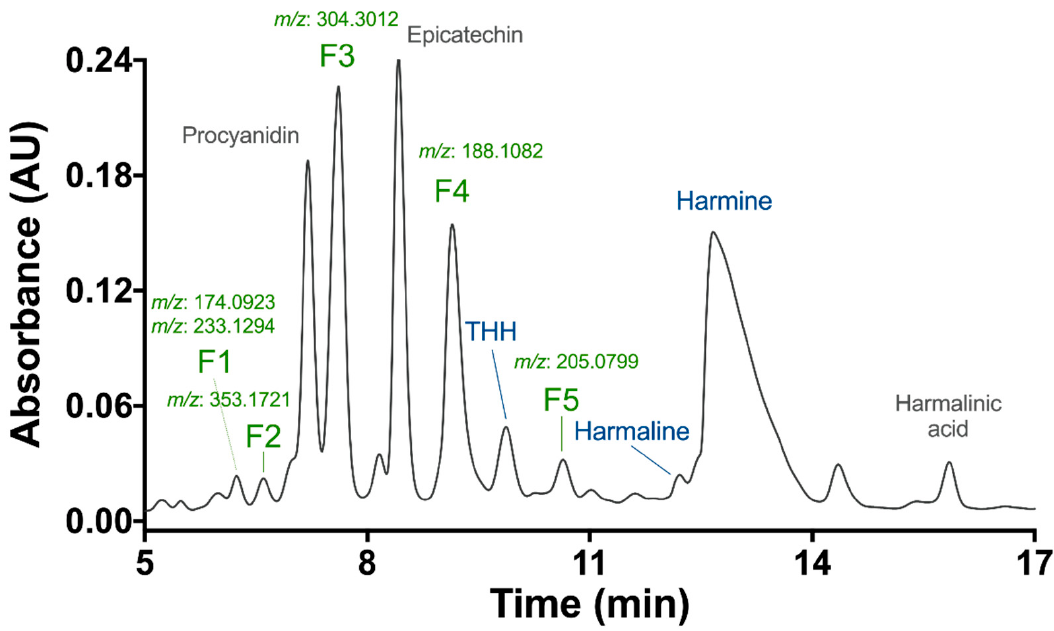
Figure 2 . HPLC-DAD chromatogram of a Banisteriopsis caapi methanolic extract, at 230 nm. Putative identification of procyanidin and epicatechin (Samoylenko et al., 2010) and harmalinic acid (Hashimoto, 1975). m / z refers to the protonated ion ([M + H] + ) in the UHPLC-TripleTOF 5600+. THH: tetrahydroharmine .